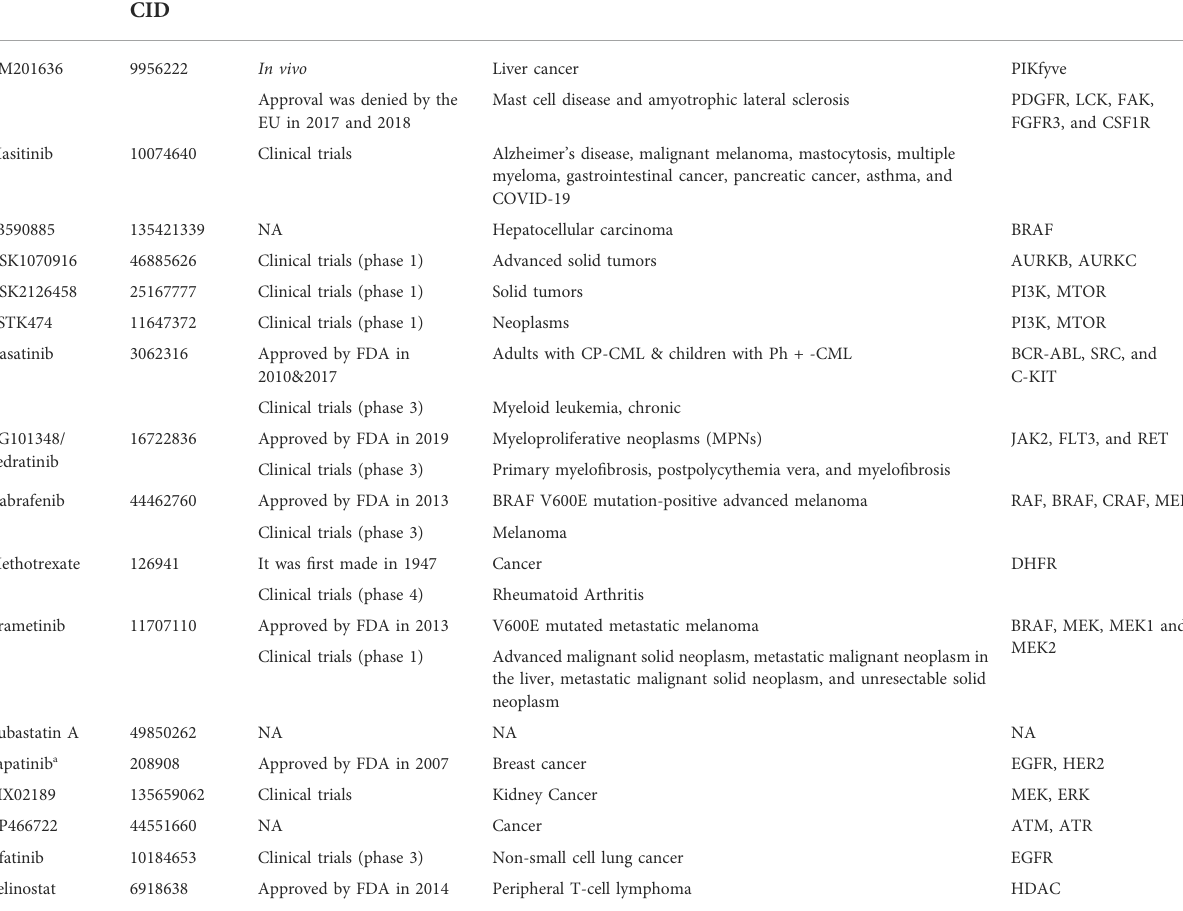
TABLE 5 List of 16 proposed repurposing drugs for